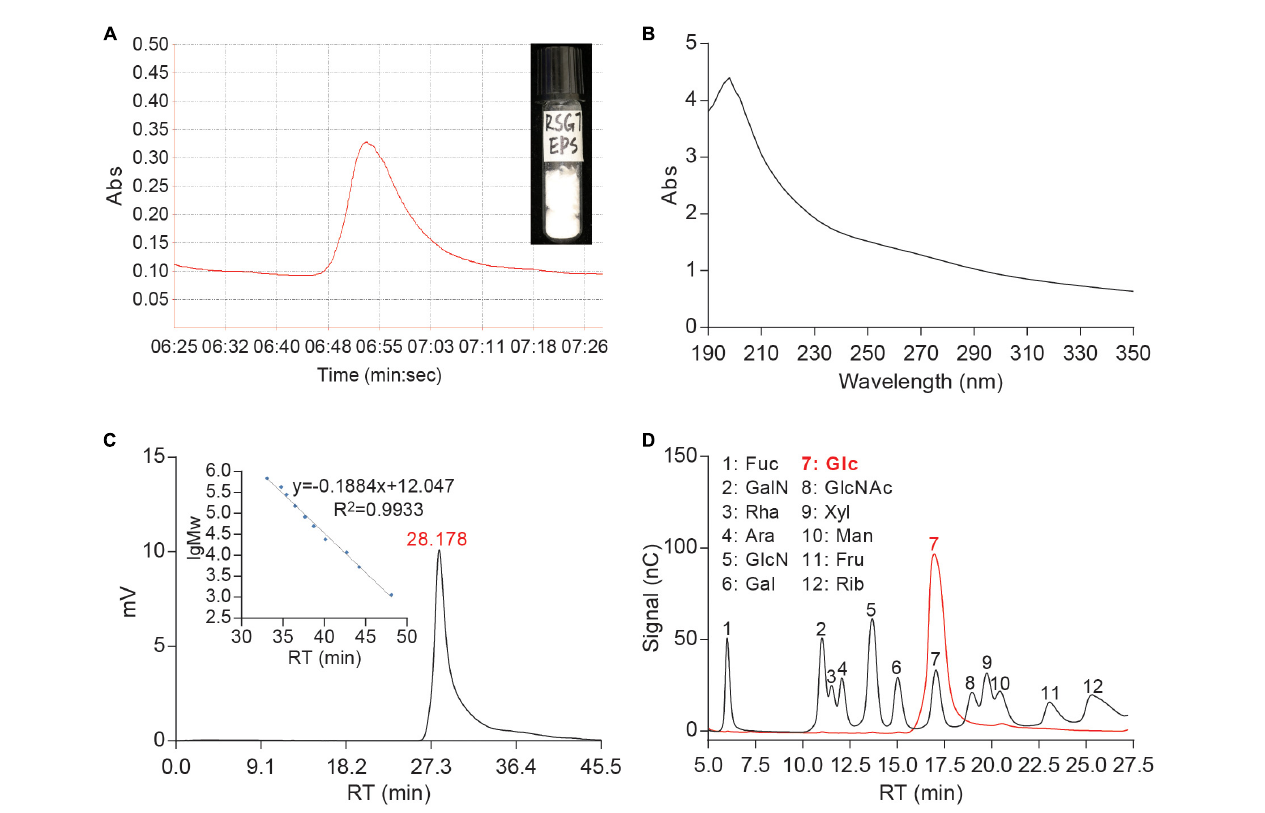
FIGURE1 Profiles of Leu. mesenteroides RSG7 exopolysaccharide (EPS). (A) Sephadex G-100 chromatogram, (B) ultraviolet (UV) spectra, (C) molecular weight (Mw), and (D) monosaccharide